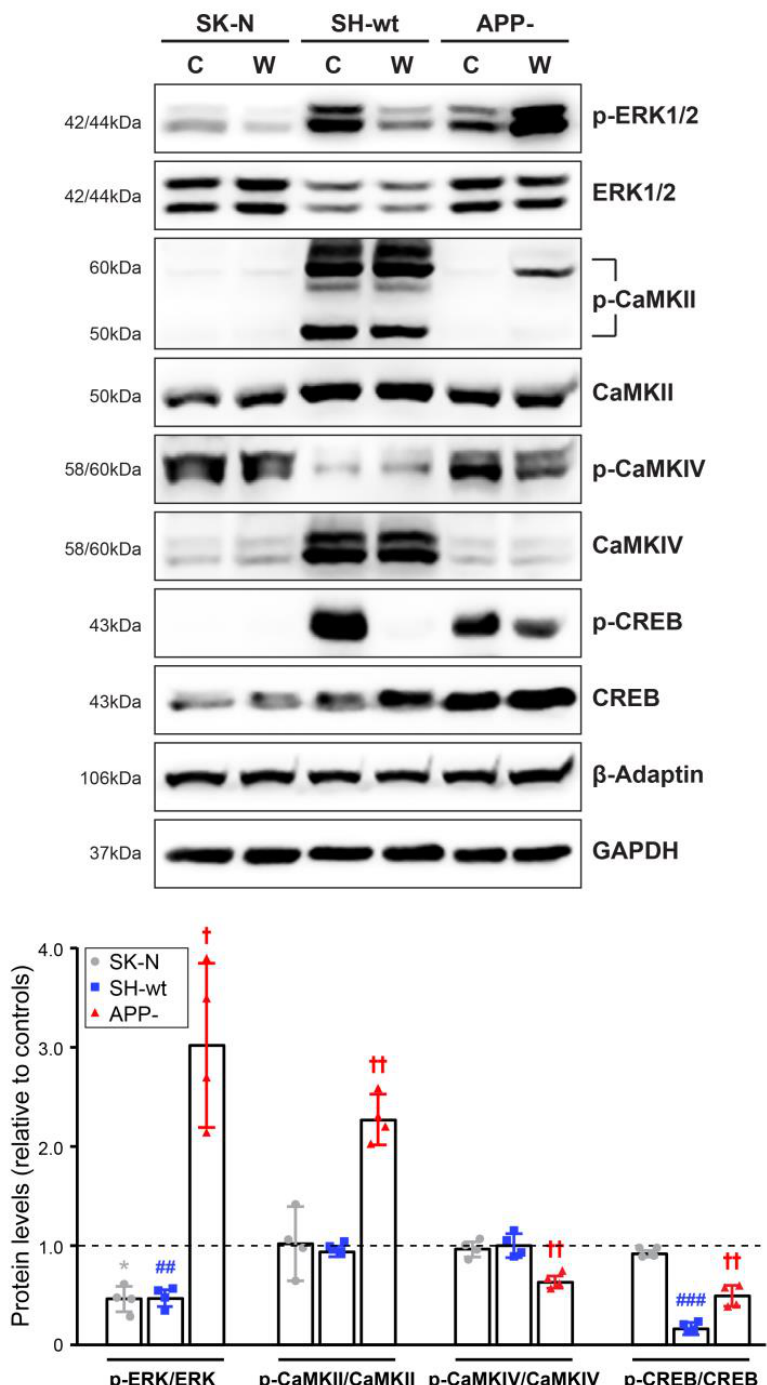
Figure 6. Inhibition of p-AKT by wortmannin activates ERK1/2 and CaMKII in SH-SY5Y/APP- cells. Representative immunoblots and quantification of the levels of ERK1/2, CaMKII, CaMKIV, CREB, and their phosphorylated forms in total protein extracts (40 µ g/lane) from SH-SY5Y (SH-wt), SH-SY5Y/APP- (APP-), and SK-N-SH (SK-N) cells, after treatment with 100 nM wortmannin (W) for 2 h. GAPDH or β -Adaptin was used as loading controls for normalization. The molecular weights of the proteins are depicted on the left of each blot image. Data are presented as arbitrary units (a.u.) of the mean ± S.D. ratio of the pixel intensity of the phosphorylated bands to the intensity of ERK1/2, CaMKII, CaMKIV, CREB total levels in treated cells (W) relative to their respective untreated-control cells (C, set at 1, indicated with a dashed line). Dots represent individual data points from four biological replicates. Statistical significance was evaluated by one-way ANOVA followed by